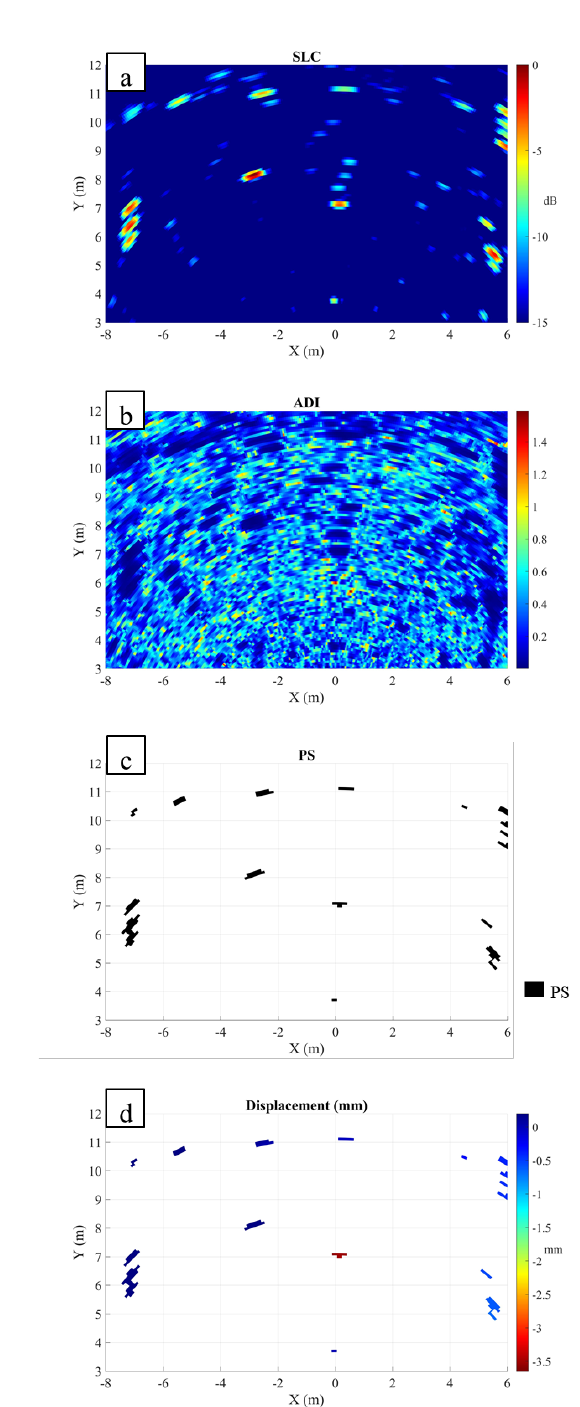
Figure 4. MIMO GBSAR measurement results: (a) SLC image Figure 3. MIMO radar measurement results: (a) SLC image of of the first epoch. (b) ADI of TS images (c) detected PS areas. the first epoch. (b) ADI of TS images (c) detected PS areas. (d) (d) Displacement Displacement map